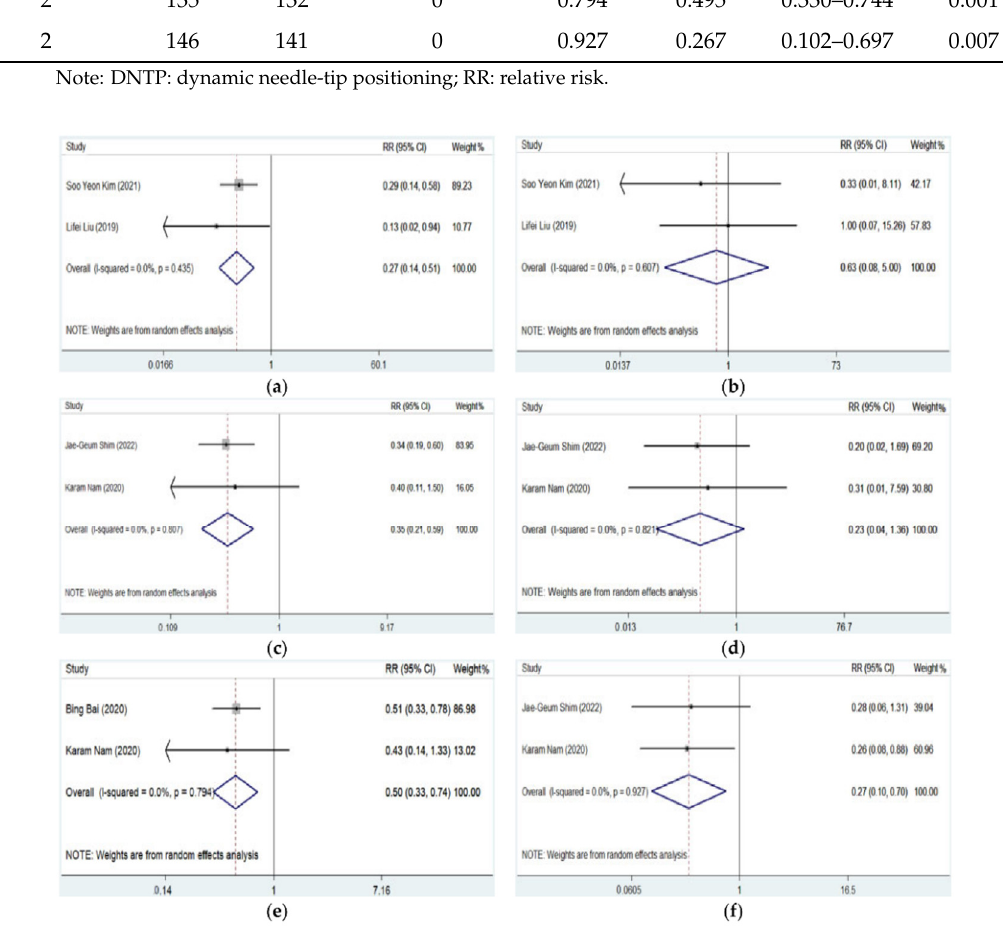
Figure 5. Forest plots for complications of artery catheterization guided by DNTP vs. palpation or traditional ultrasound approach [9–12,16]. ( a ) Occurrence of hematoma of DNTP vs. palpation; ( b ) occurrence of thrombosis of DNTP vs. palpation; ( c ) occurrence of hematoma of DNTP vs. tradi- tional ultrasound; ( d ) occurrence of thrombosis of DNTP vs. traditional ultrasound; ( e ) occurrence of posterior wall punctures of DNTP vs. traditional ultrasound; ( f ) occurrence of vasospasm of DNTP vs. traditional ultrasound. Table 4. Meta-analysis and subgroup analysis in complications of DNTP vs. palpation or tradi- tional ultrasound method.